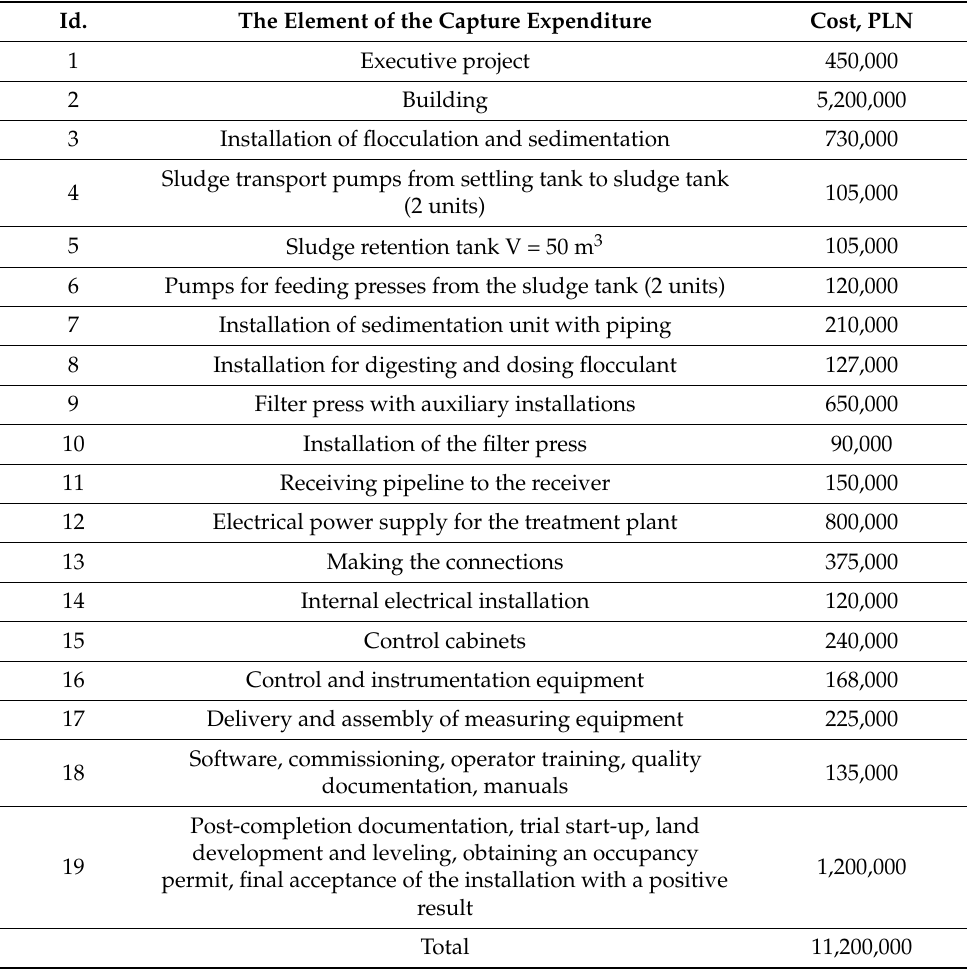
Table 1. The investment cost of the treatment installation.